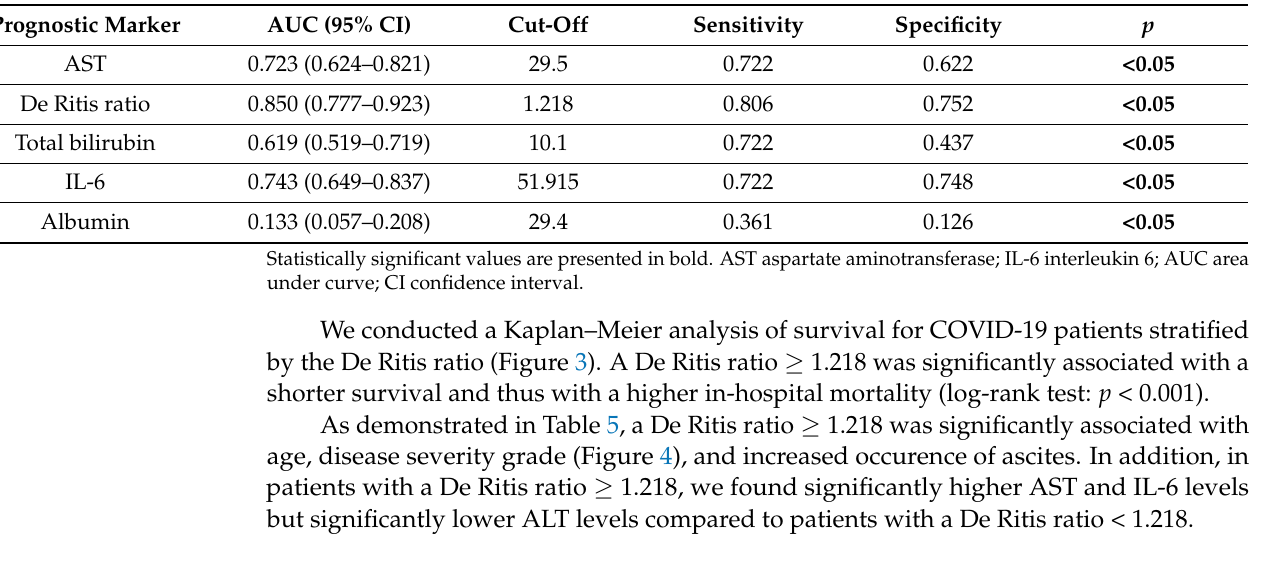
Figure 2. ROC curves of De Ritis ratio, AST, total bilirubin, albumin, and IL-6. ROC, Receiver Operating Characteristic; AST, aspartate aminotransferase; IL-6, interleukin 6. Table 4. Diagnostic accuracy of the five investigated laboratory